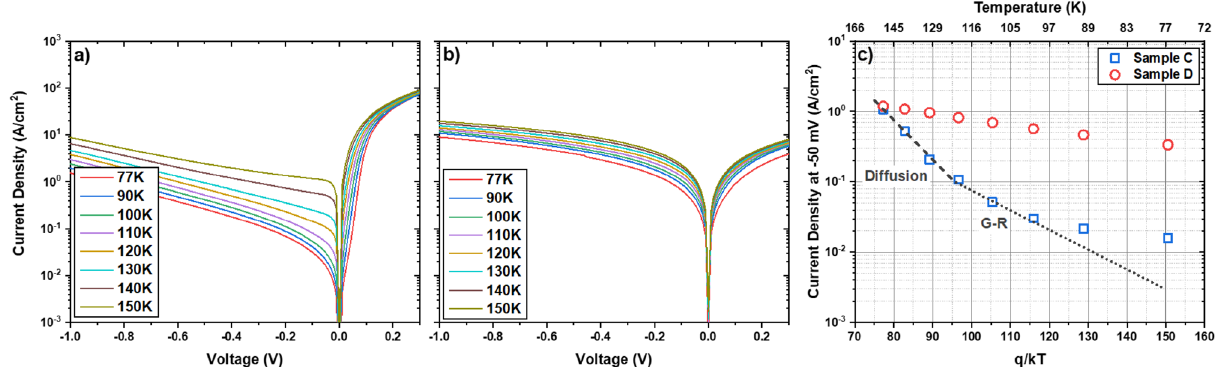
Figure 5. Dark current density for the temperature range 77 K–150 K for Sample C ( a ) and Sample D ( b ). Arrhenius plot of current density at −50 mV for Samples C and D ( c ).